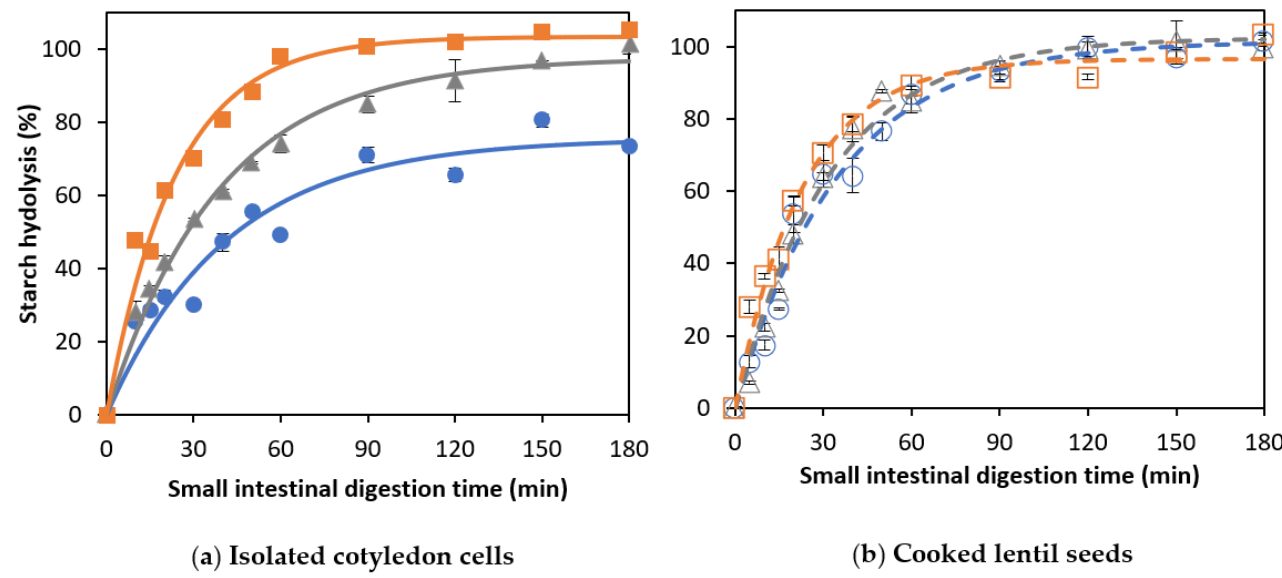
Figure 3. In vitro amylolysis as a function of the small intestinal digestion time of ( a ) cells isolated from lentils cooked for ( ○ )15, ( ∆ ) 30, or ( □ ) 60 min and ( b ) whole cooked lentils cooked for ( ● ) 15, ( ▲ ) 30, or ( ■ ) 60 minutes. Symbols represent experimentally determined data. Lines represent the data modeled using the fractional conversion model (Equation (3)). Error bars indicate the standard deviation of the analytical replicates.